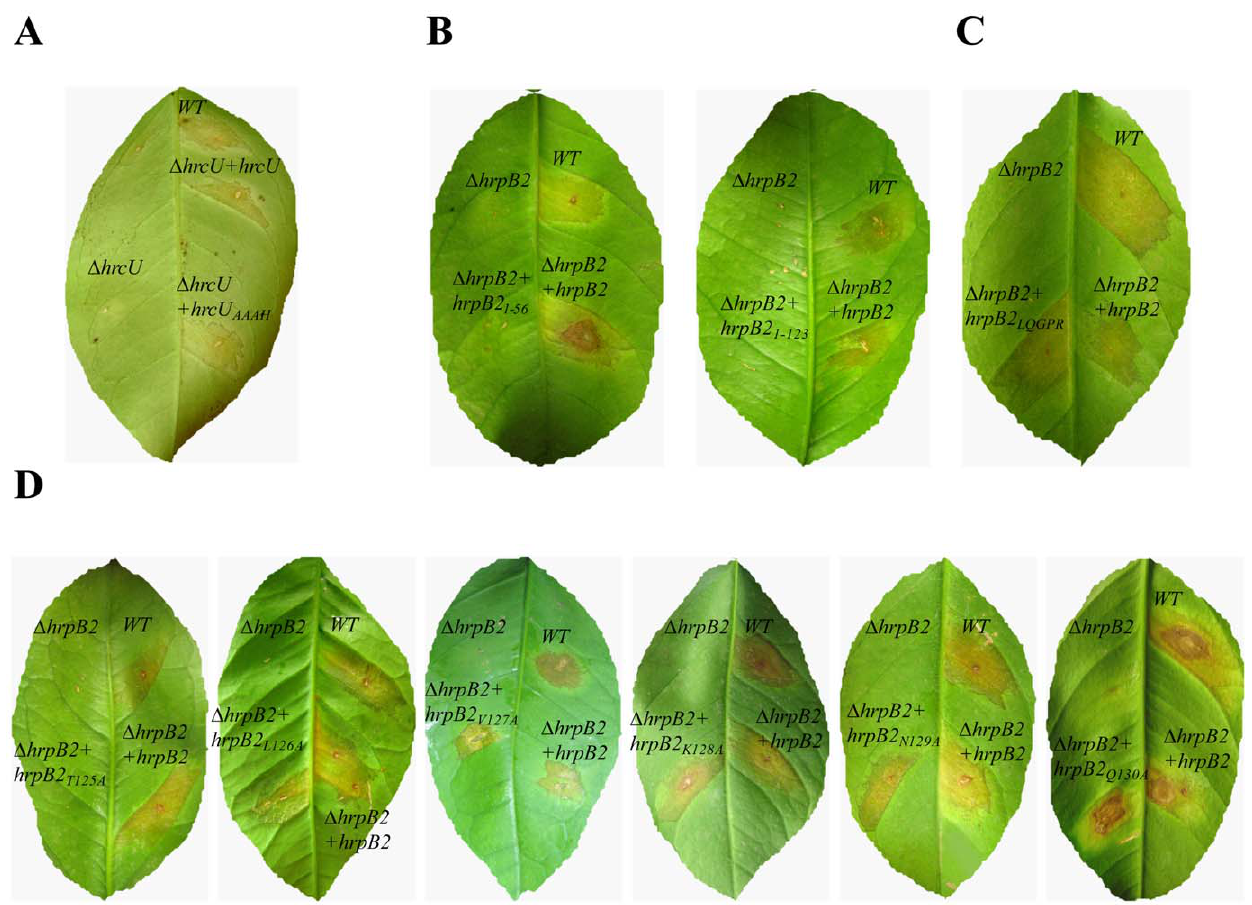
Figure 4. HrcU and HrpB2 contribute to Xac pathogenicity during infection of Citrussinensis . Macroscopic symptoms 15 days after inoculation on the abaxial surface of leafs with D hrcU ( A ) and D hrpB2 ( B-D ) mutants. The following strains were used: Xac wild-type (WT), D hrcU , D hrcU + pUFR047_ hrcU ( D hrcU + hrcU ), D hrcU + pUFR047_ hrcU AAAH ( D hrcU + hrcU AAAH ), D hrpB2, D hrpB2 + pUFR047 _hrpB2 ( D hrpB2 + hrpB2) , D hrpB2 + pUFR047 _hrpB2 1-56 ( D hrpB2 + hrpB2 1-56 ), D hrpB2 + pUFR047 _hrpB2 1-123 ( D hrpB2 + hrpB2 1-123 ), D hrpB2 + pUFR047_hrpB2 LQGPR ( D hrpB2 + hrpB2 LQGPR ) , D hrpB2 + pUFR047 _hrpB2 T125A ( D hrpB2 + hrpB2 T125A ), D hrpB2 + pUFR047 _hrpB2 L126A ( D hrpB2 + hrpB2 L126A ), D hrpB2 + pUFR047 _hrpB2 V127A ( D hrpB2 + hrpB2 V127A ), D hrpB2 + pUFR047 _hrpB2 K128A ( D hrpB2 + hrpB2 K128A ), D hrpB2 + pUFR047 _hrpB2 N129A ( D hrpB2 + hrpB2 N129A ) and D hrpB2 + pUFR047 _hrpB2 L130A ( D hrpB2 + hrpB2 L130A ).